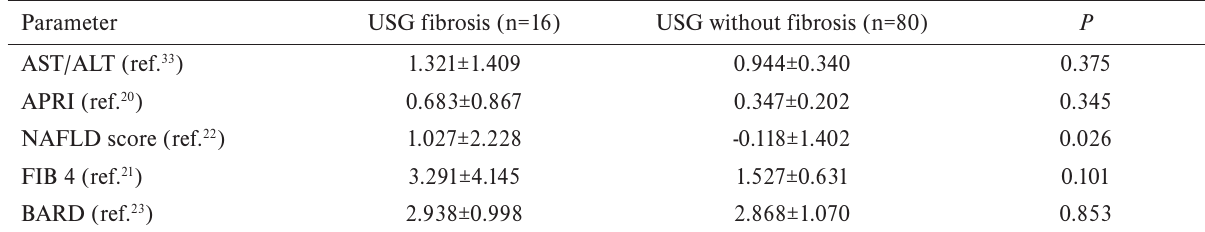
Table 5. Scoring systems* for liver fibrosis assessment in patients with ultrasound signs of hepatic fibrosis or cirrhosis and in those with ultrasound signs of simple steatosis. USG fibrosis